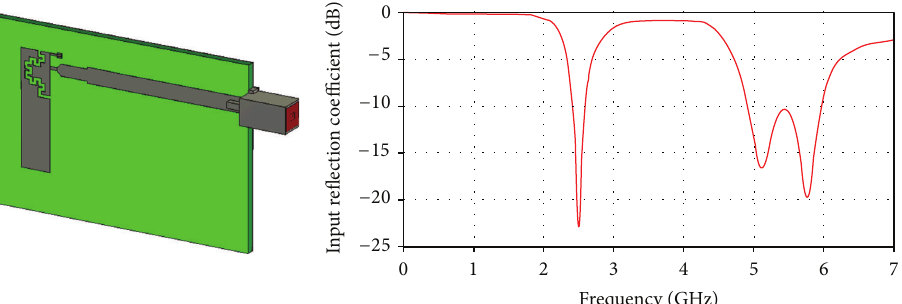
Figure 8: The computational model of the dual-band D-GK2 PIFA in perspective and the magnitude of its input reflection coefficient in the range